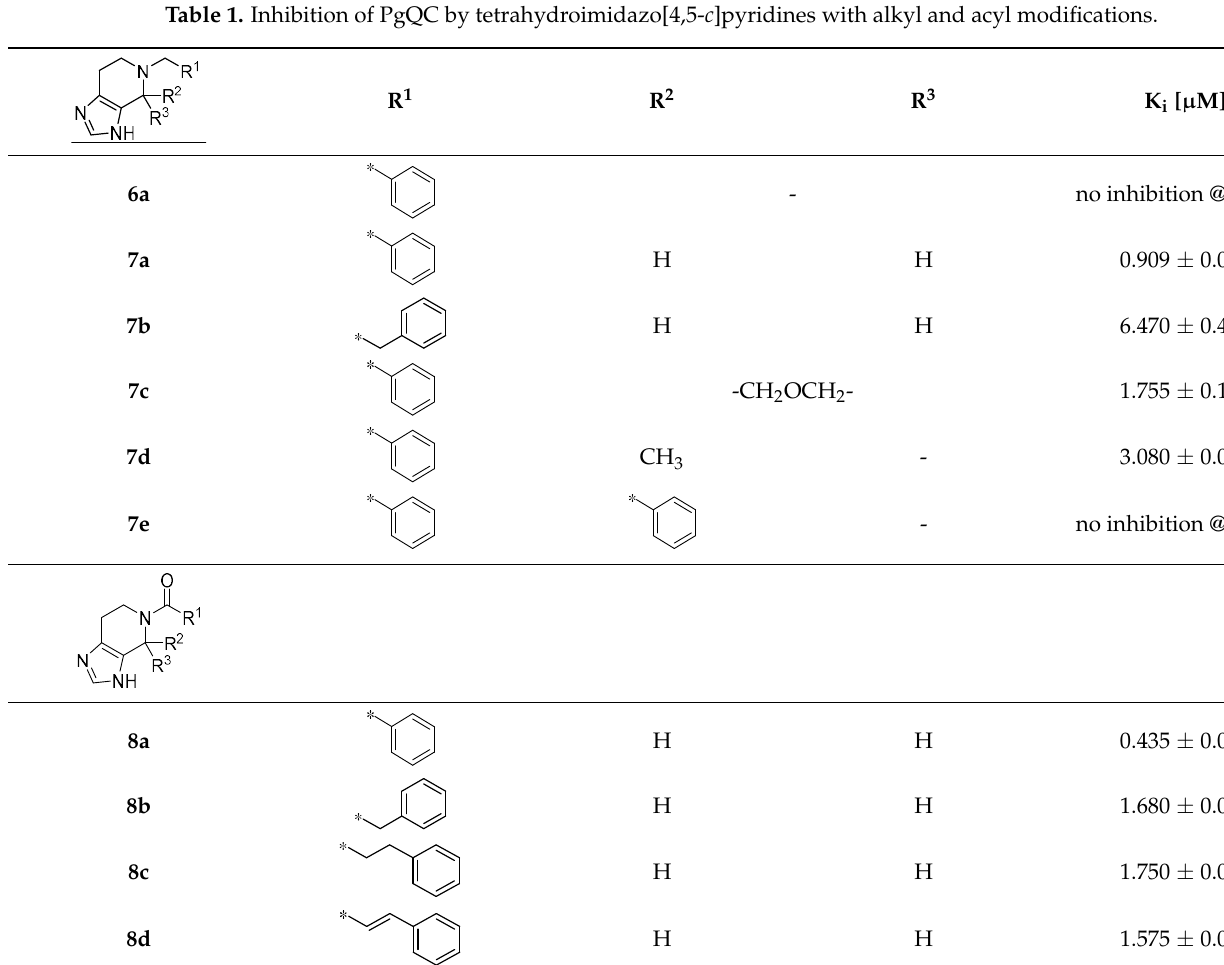
Table 1. Inhibition of PgQC by tetrahydroimidazo[4,5- c ]pyridines with alkyl and acyl modifications.